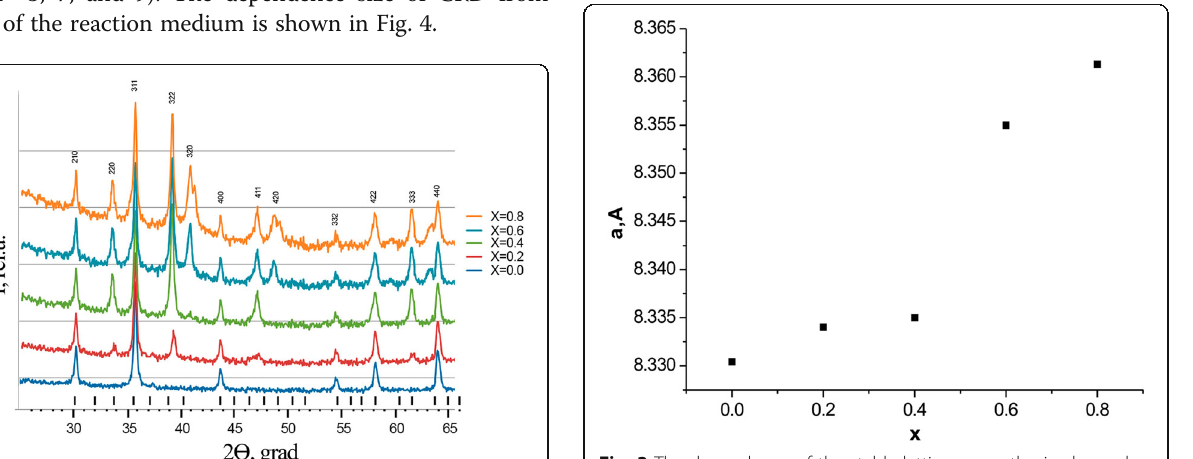
Fig. 3 The dependence of the stable lattice on synthesized samples of the